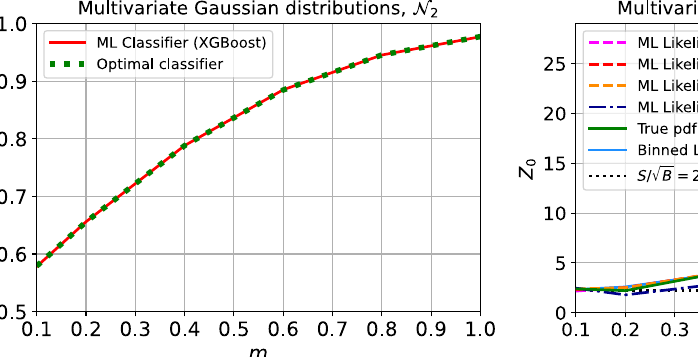
(cid:8) B (cid:9) = 50k and (cid:8) S (cid:9) = 500. Color coding is the same as in Fig. 3, but we also include the results for the ML Likelihood method with dif- ferent binning choices of the classification score and the significance obtained using the estimated unbinned Likelihood Ratio